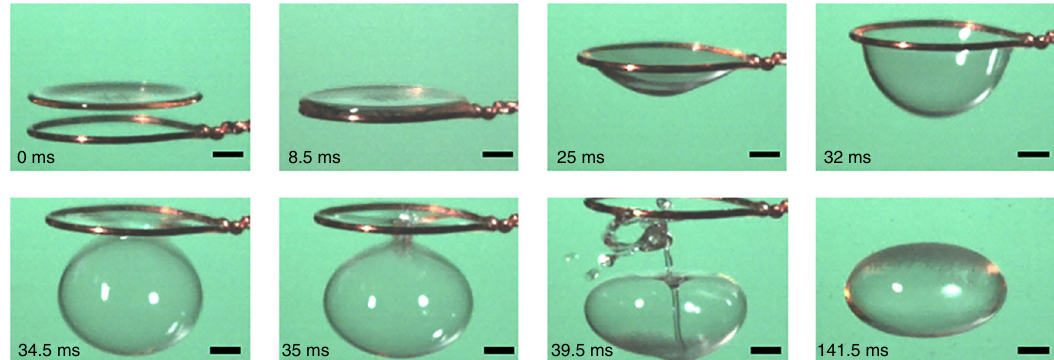
Fig. 5 Bubble formation of a liquid fi lm buckled via a rigid ring. Snapshots showing that bubble formation can be triggered by dragging a ring of metal wire constantly around the edge of the fi lm (SDS drops at CMC), which completely limited the radial oscillation of the levitated sample. Scale bars represent 1 mm